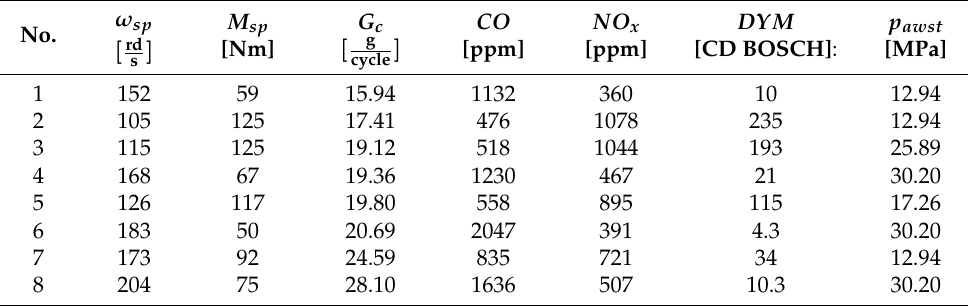
Table 5. Parameters of combustion engine duty points determined for accumulator with capacity V a = 0.02 [m 3 ] (load I).